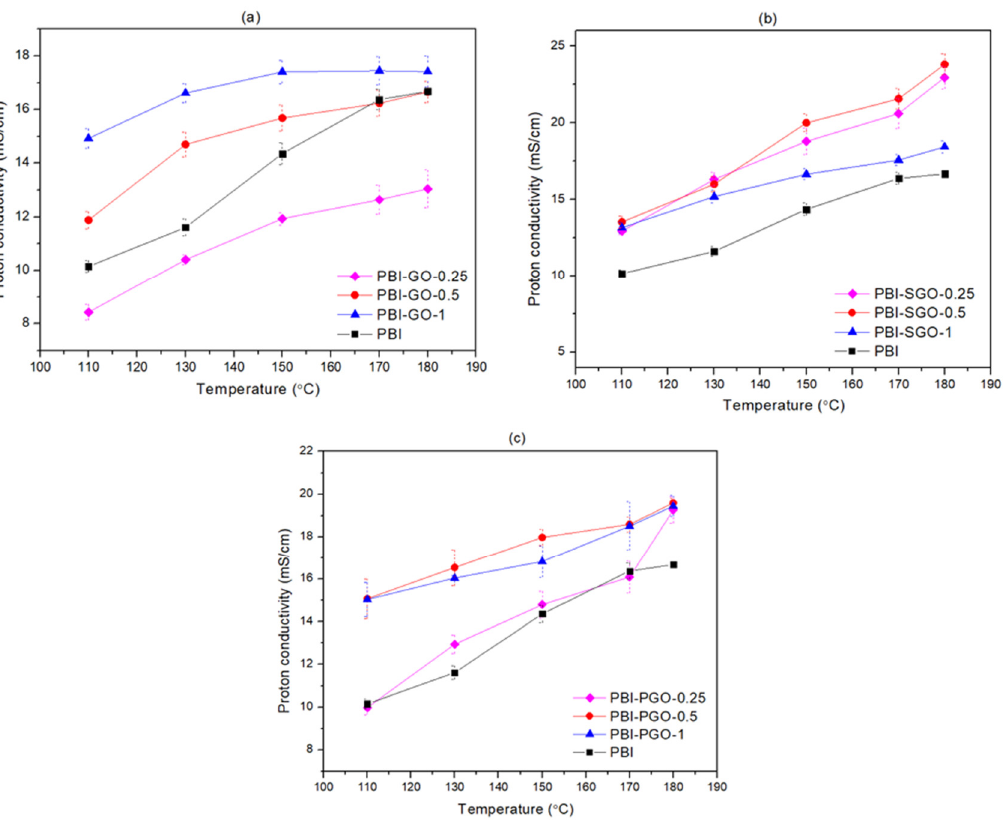
Figure 8. Proton conductivity under anhydrous conditions for ( a ) PBI-GO, ( b ) PBI-SGO, and ( c ) PBI- PGO.